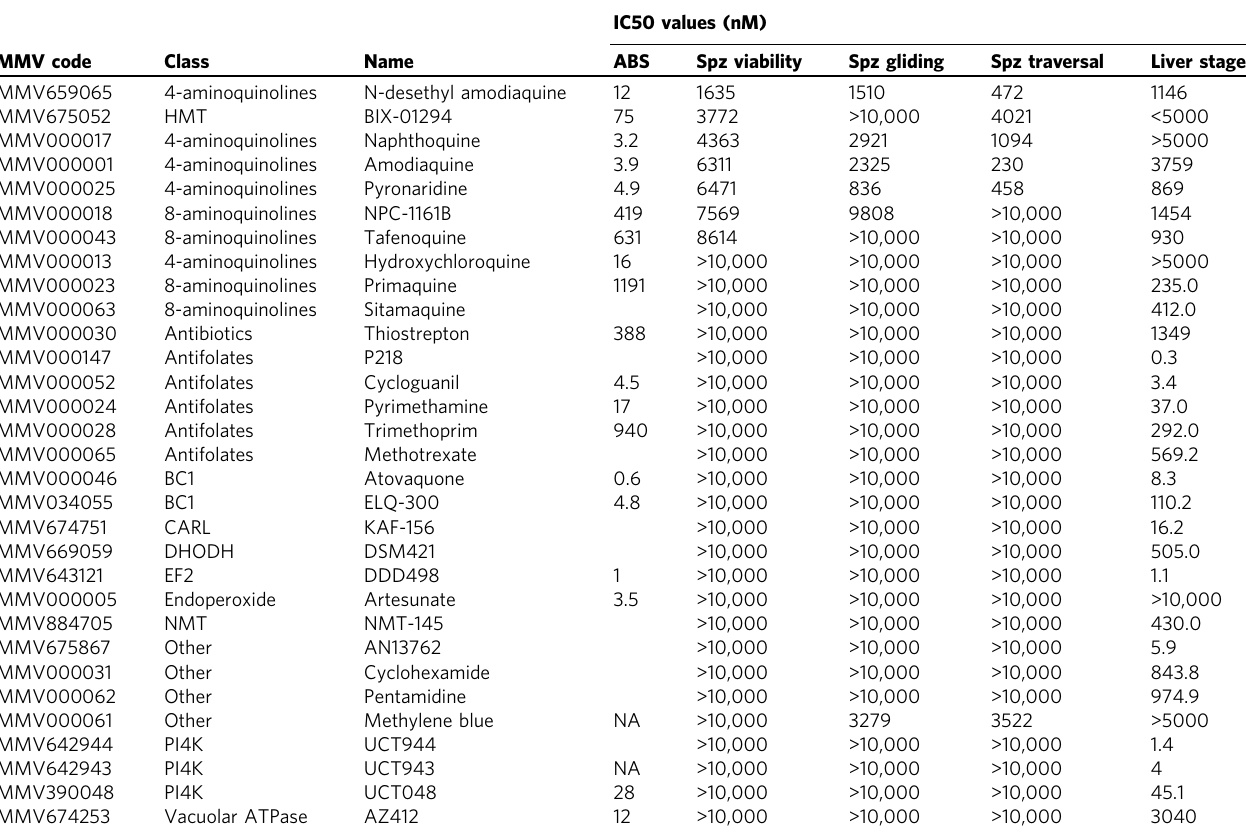
Table 1 IC50 values of selected compounds in P. falciparum NF54 sporozoite functional assays.